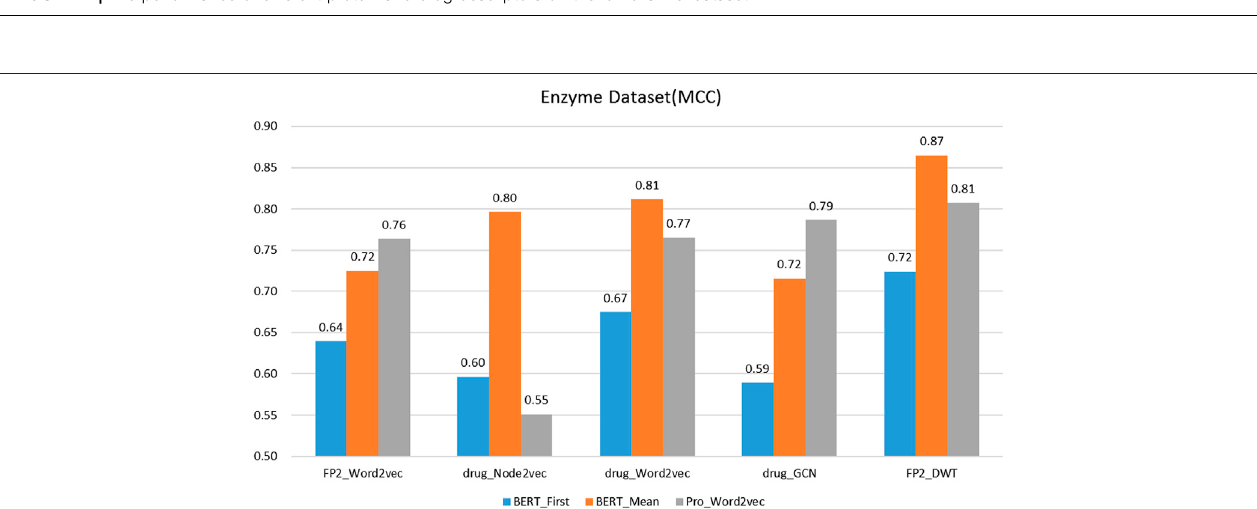
FIGURE 4 | The performance of different protein and drug descriptors on the ion channel dataset.